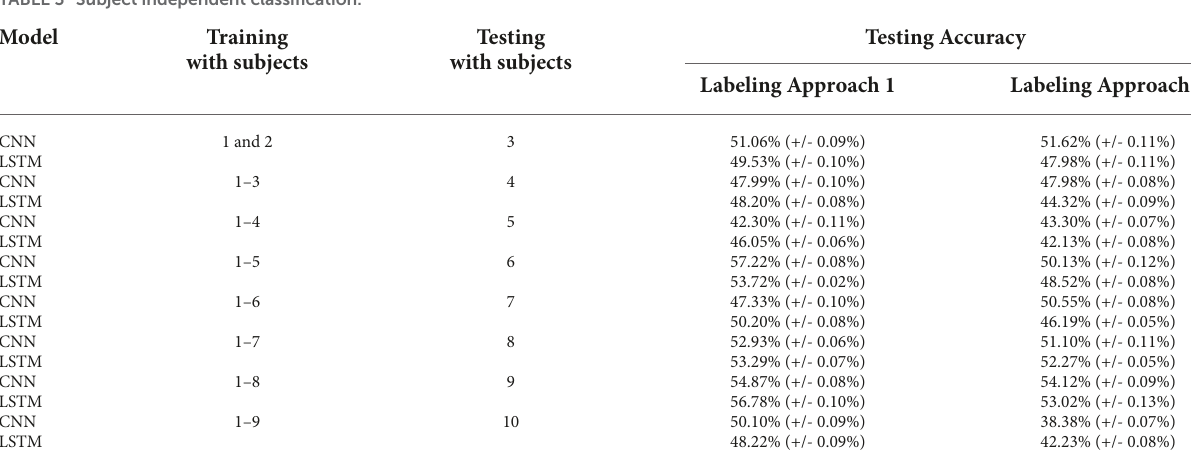
TABLE 3 Subject independent